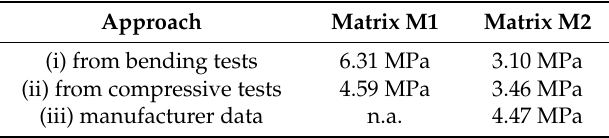
Table 9. Average matrix failure strengths f ctm